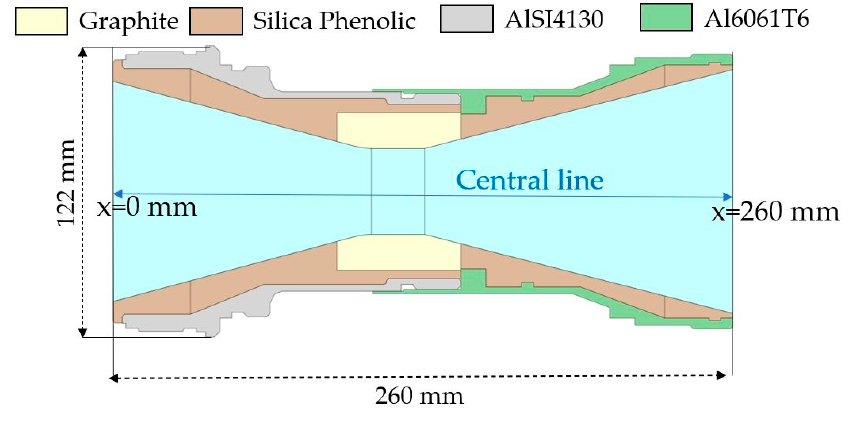
Figure 7. The solid model of the nozzle.